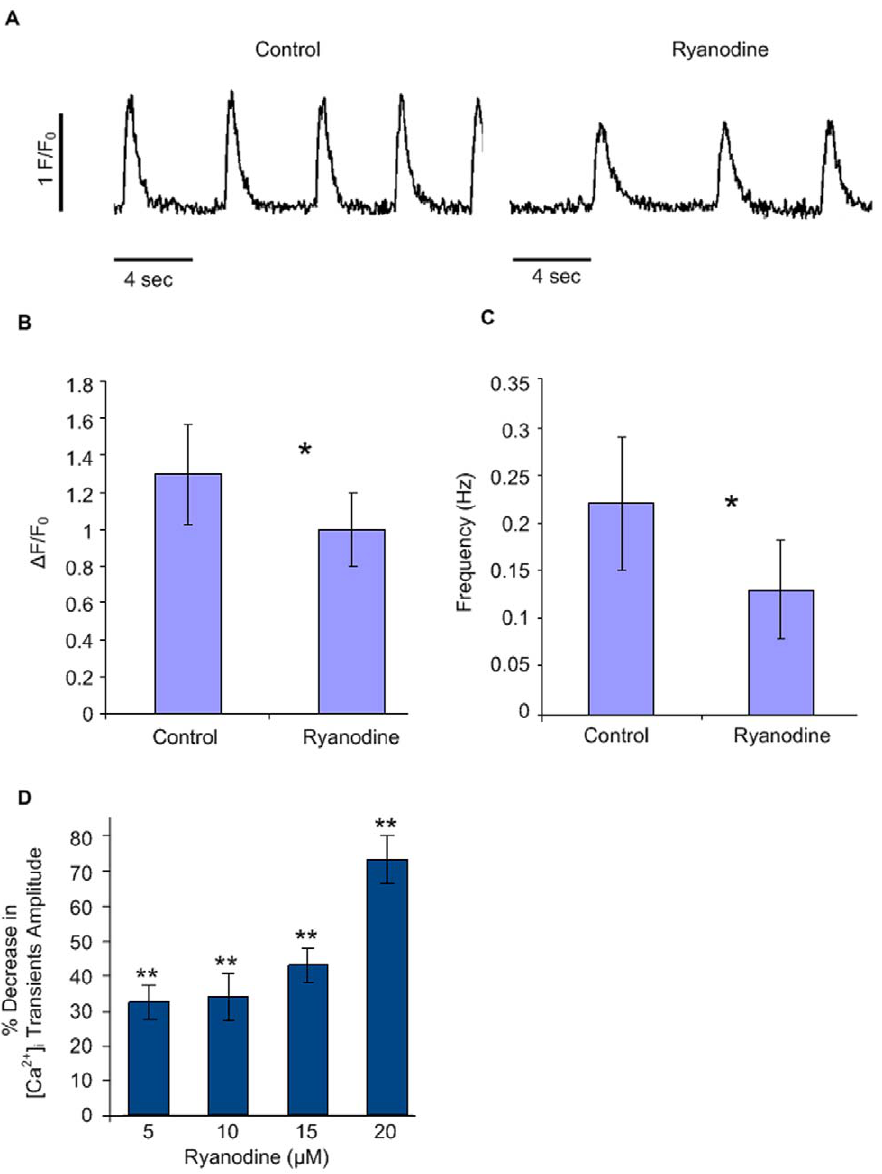
Figure 4. Ryanodine-sensitive Ca 2 + stores. ( A ) Line-scan tracings of whole-cell [Ca 2 + ] i transients recorded from a representative hIH1 hiPSC-CM under control conditions (left) and in the presence of 10 m M Ryanodine (right). ( B–C ) Summary of the ryanodine-mediated (10 m M) diminution in whole-cell [Ca 2 + ] i transients amplitude (B) and frequency (C). *p , 0.05 when compared to baseline (control) values. ( D ) Dose-response curve for the effects of ryanodine (5, 10, 15 and 20 m M) on whole-cell [Ca 2 + ] i transients amplitude displayed as the percentage of decrease from baseline values. **p , 0.01 when mean absolute values were compared to baseline values. Abbreviations: F/Fo, fluorescence (F) normalized to baseline fluorescence (Fo); sec,